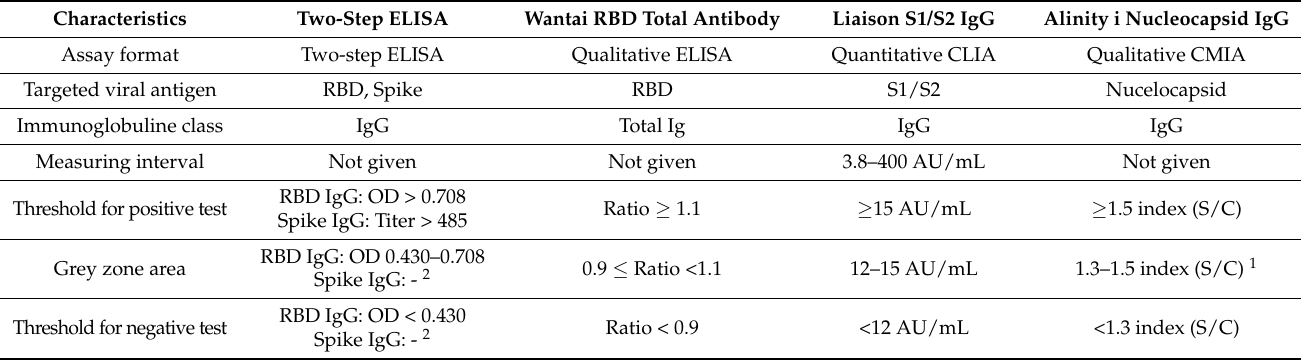
Table 1. Characteristics of the serological assays included in the study.